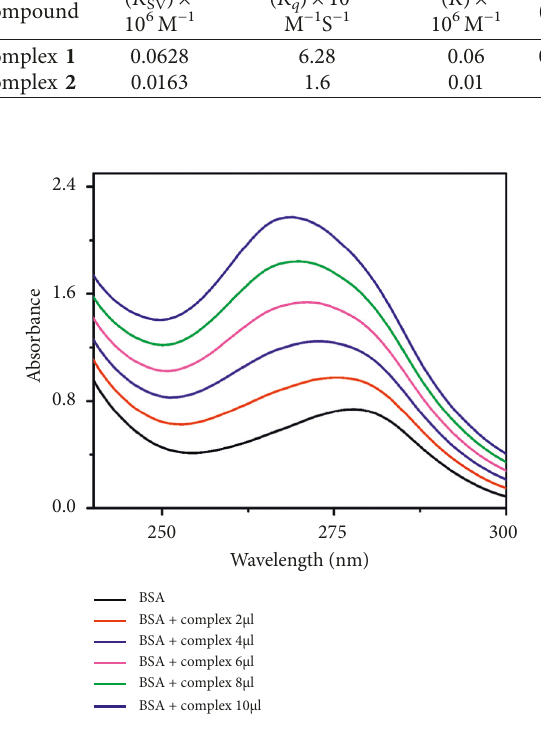
Figure 15: UV absorption titration of complex 1 (0–10 µ l) with BSA (1 µ M) in PBS buffer (pH 7.4).